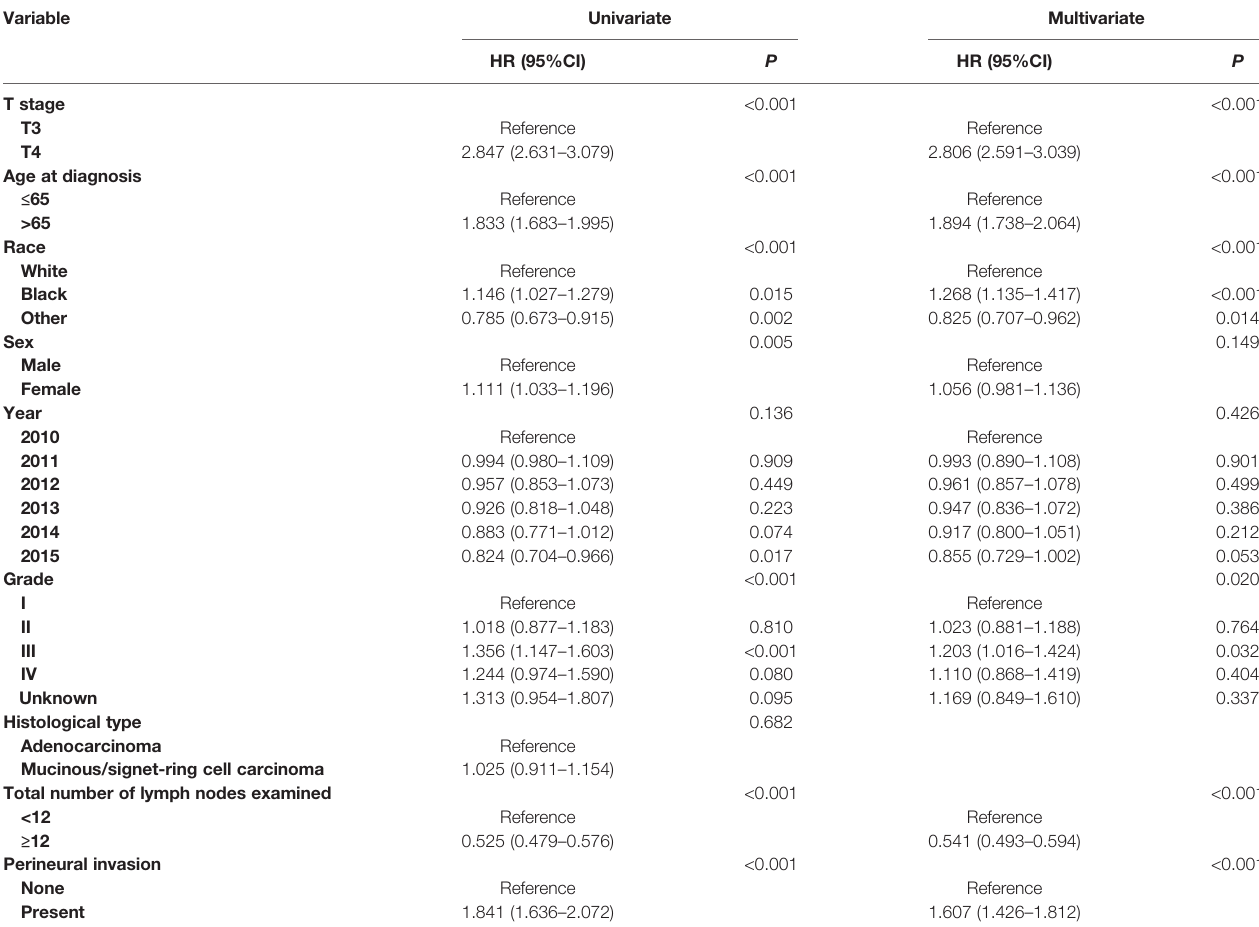
TABLE 3 | Univariate and multivariate survival analyses of stage II colon